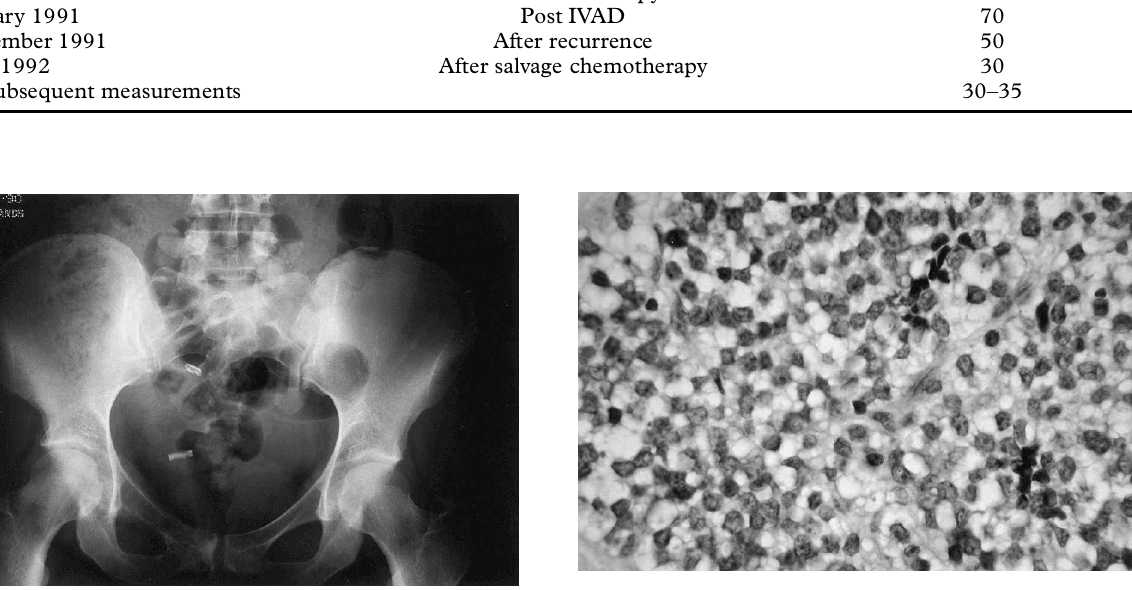
Fig. 1. (a) Radiograph of the pelvis demonstrating a tumour of the right superior pubic ramus. (b) Histology (H&E) characteristic of Ewing’s sarcoma.